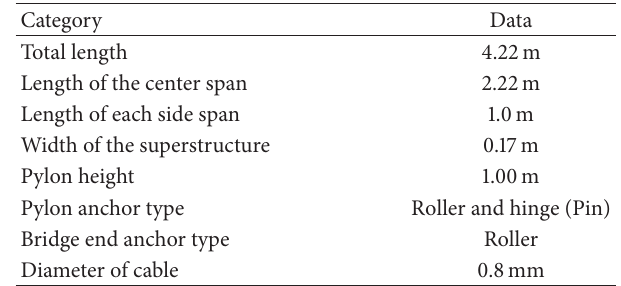
Table 1: Design data of the cable-stayed bridge